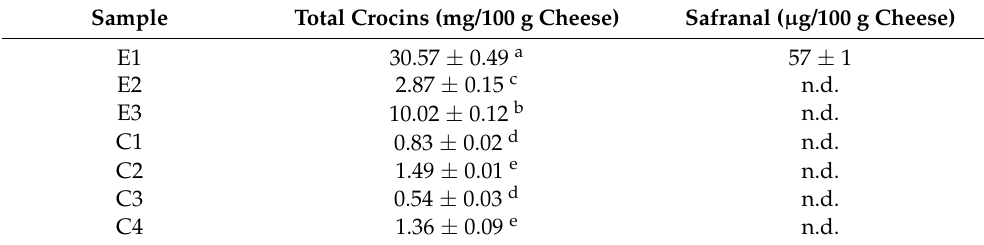
Table 1. Characterization of saffron bioactive compounds in cheese (mg/100 g cheese): total crocins and safranal. Different superscript letters in the same column correspond to significantly different mean values ( p < 0.05).